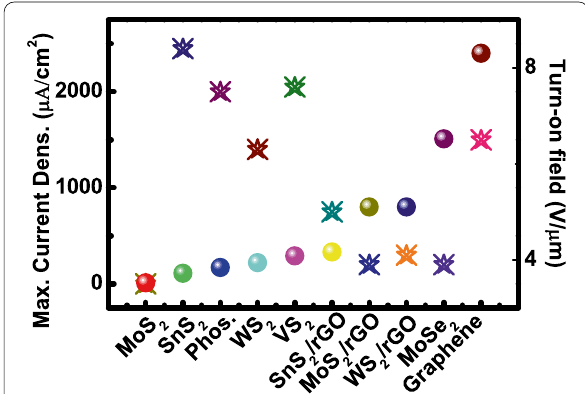
Fig. 9 Field Emission parameters of the 2D materials and their